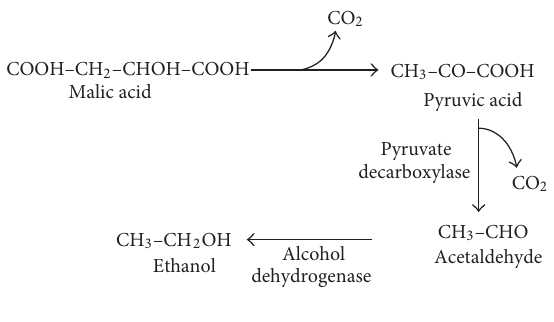
F 5: Enzymatic reactions of carbonic maceration.